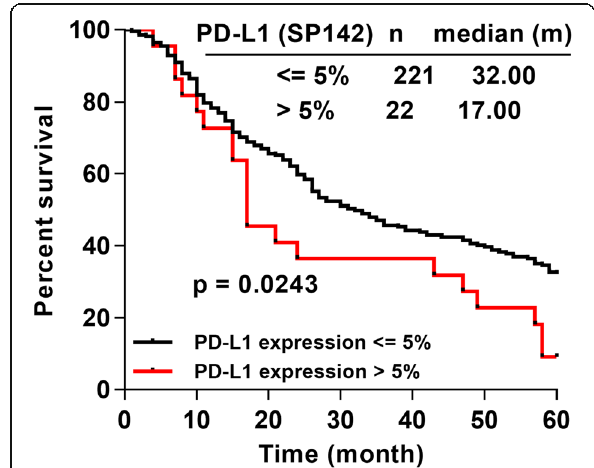
Fig. 3 The correlation between five-year OS and PD-L1 expression. The positive expression of the clone SP142 at the 5% cut-off value was correlated with a worse prognosis (log-rank test). “ n ” represented the numbers of patients displaying staining less than or equal to 5% cut- off value and those displaying staining greater than the 5% cut-off